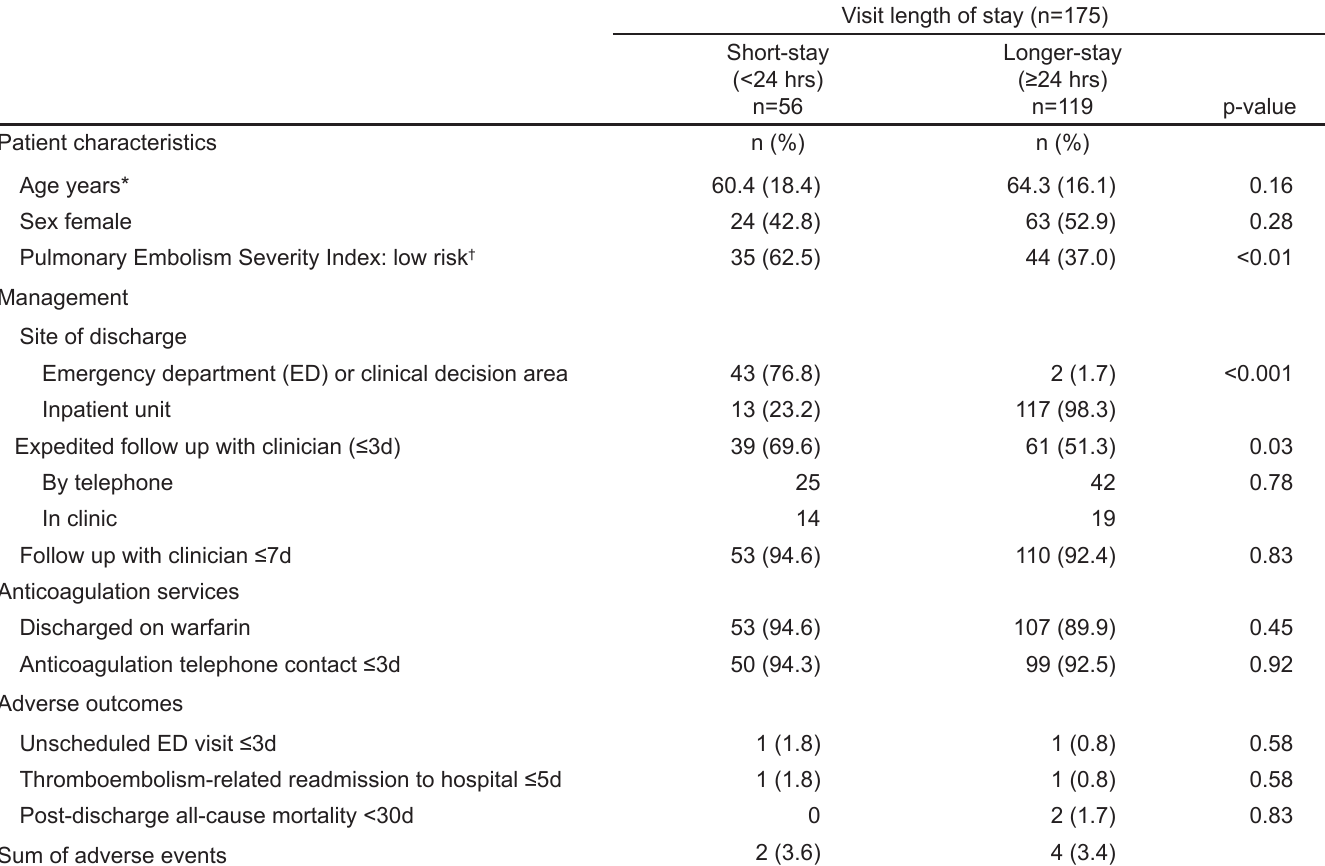
Table 1. Patient characteristics, management, and outcomes of patients with acute pulmonary embolism stratified by facility length of stay.